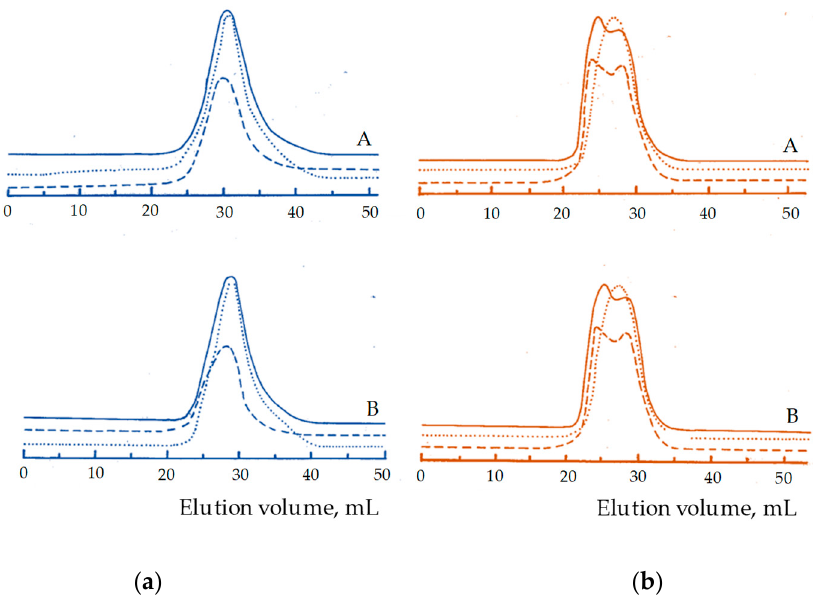
Figure 2. SEC eluograms of copolymers obtained after ( a ) simultaneous introduction of comonomers (STEM 1, Table 1) and ( b ) consecutive St/MMA/EO addition (STEM 2, Table 1). A—copolymerization mixture; B—copolymer isolated after two selective extractions. Detector signals: ( ____ ) dRI, (- - -) UV and ( ….. ) IR.